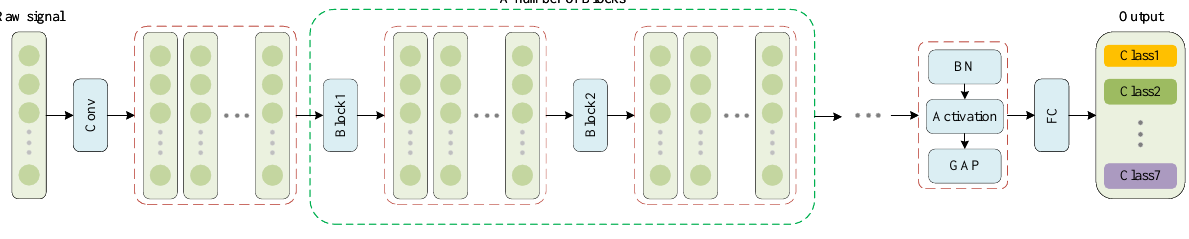
Figure 3. Structure of neural network.